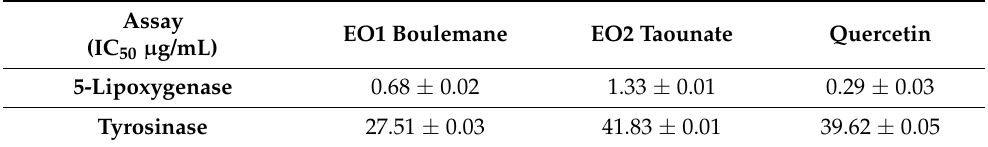
Table 3. In vitro anti-inflammatory and dermatoprotective activity.